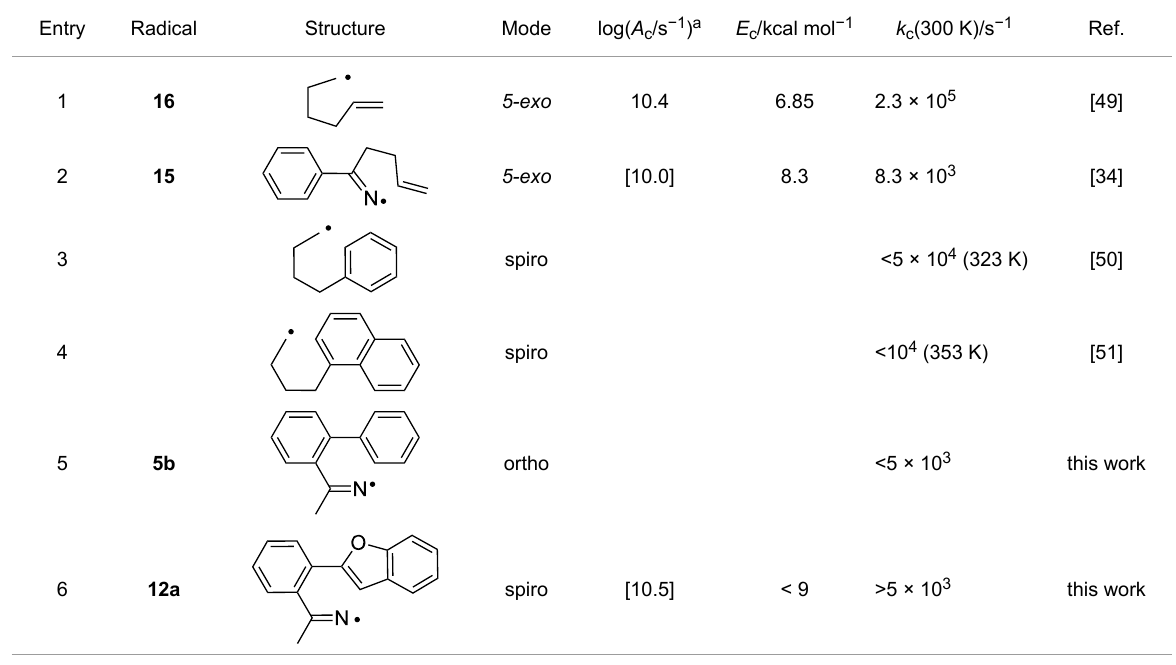
Table 3: Rate data for spiro- and other cyclisations of C- and N-centred radicals.